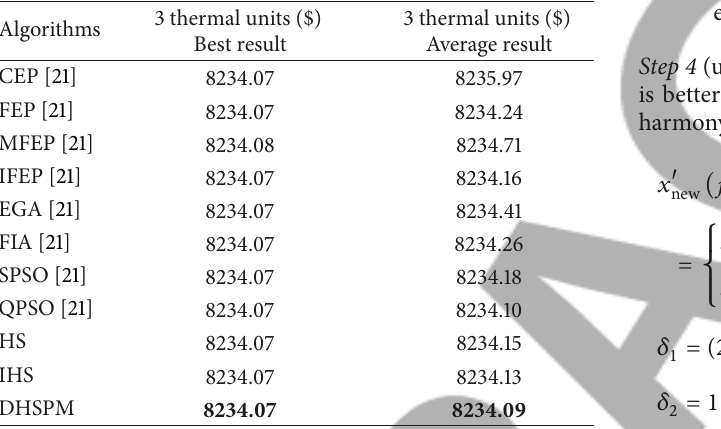
Table 5: Best result comparison with different algorithms for 3 thermal units’